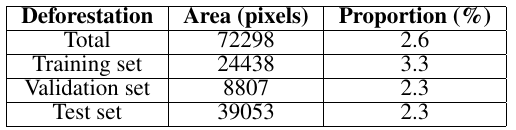
Table 1. Deforestation area in the study region.